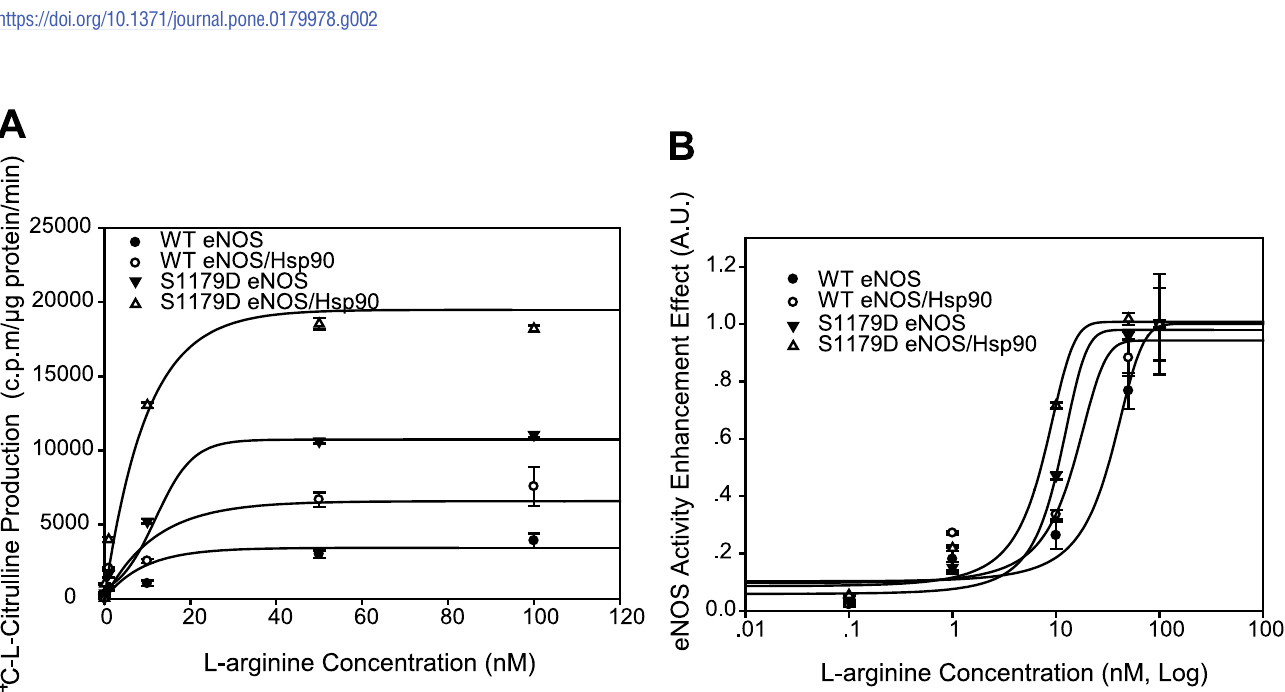
Fig 3. Hsp90 enhanced WT eNOS but not S1179DeNOS affinity to L-arginine. (A) Hsp90augmentedboth WT eNOS and S1179D eNOS activity capacity in the presenceof L-arginine(n = 5). (B) L-arginine-eNOS activity dynamic assay showedthat Hsp90 enhancedWTeNOS (EC50, P < 0.05; n = 5) but not mutant S1179Dsensitivity to L-arginine(EC50, P > 0.05;n = 5). However, mutation of S1179Dsignificantly enhanced eNOS affinity to L- argininecomparedto their WT eNOS control in the absenceand presenceof Hsp90 (EC50, P < 0.05; n = 5).